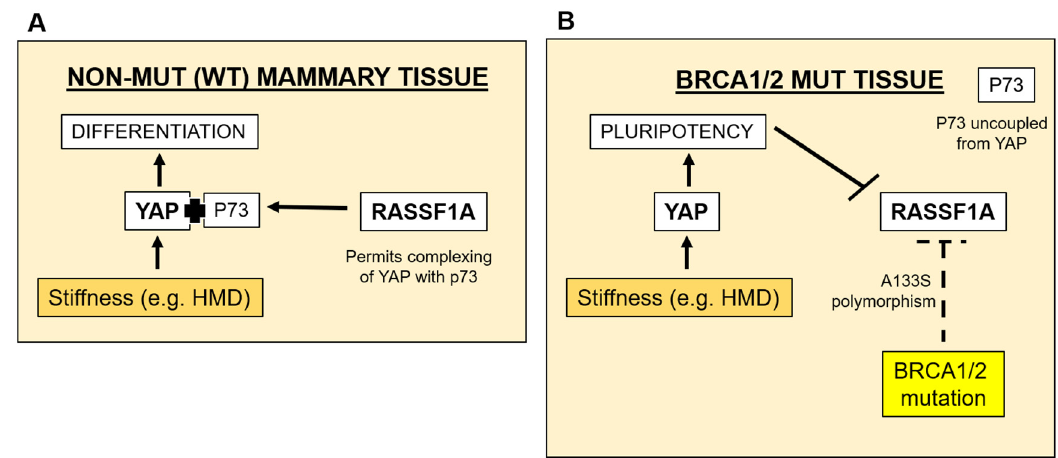
Figure 6. Schematic depicting a possible feedback mechanism through which RASSF1A is repressed in pre-malignant mammary tissue not harbouring BRCA mutations (A) or harbouring BRCA1/2 mutations (B).